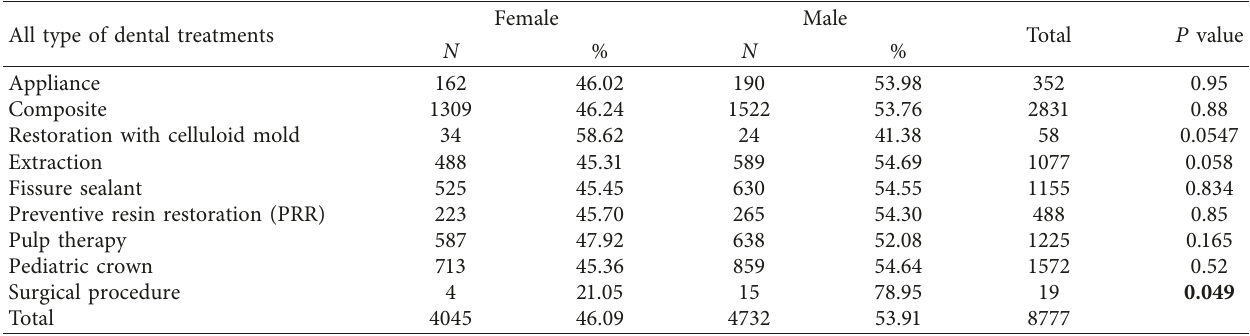
Table 3: Comparison between each type of dental treatment and gender types.